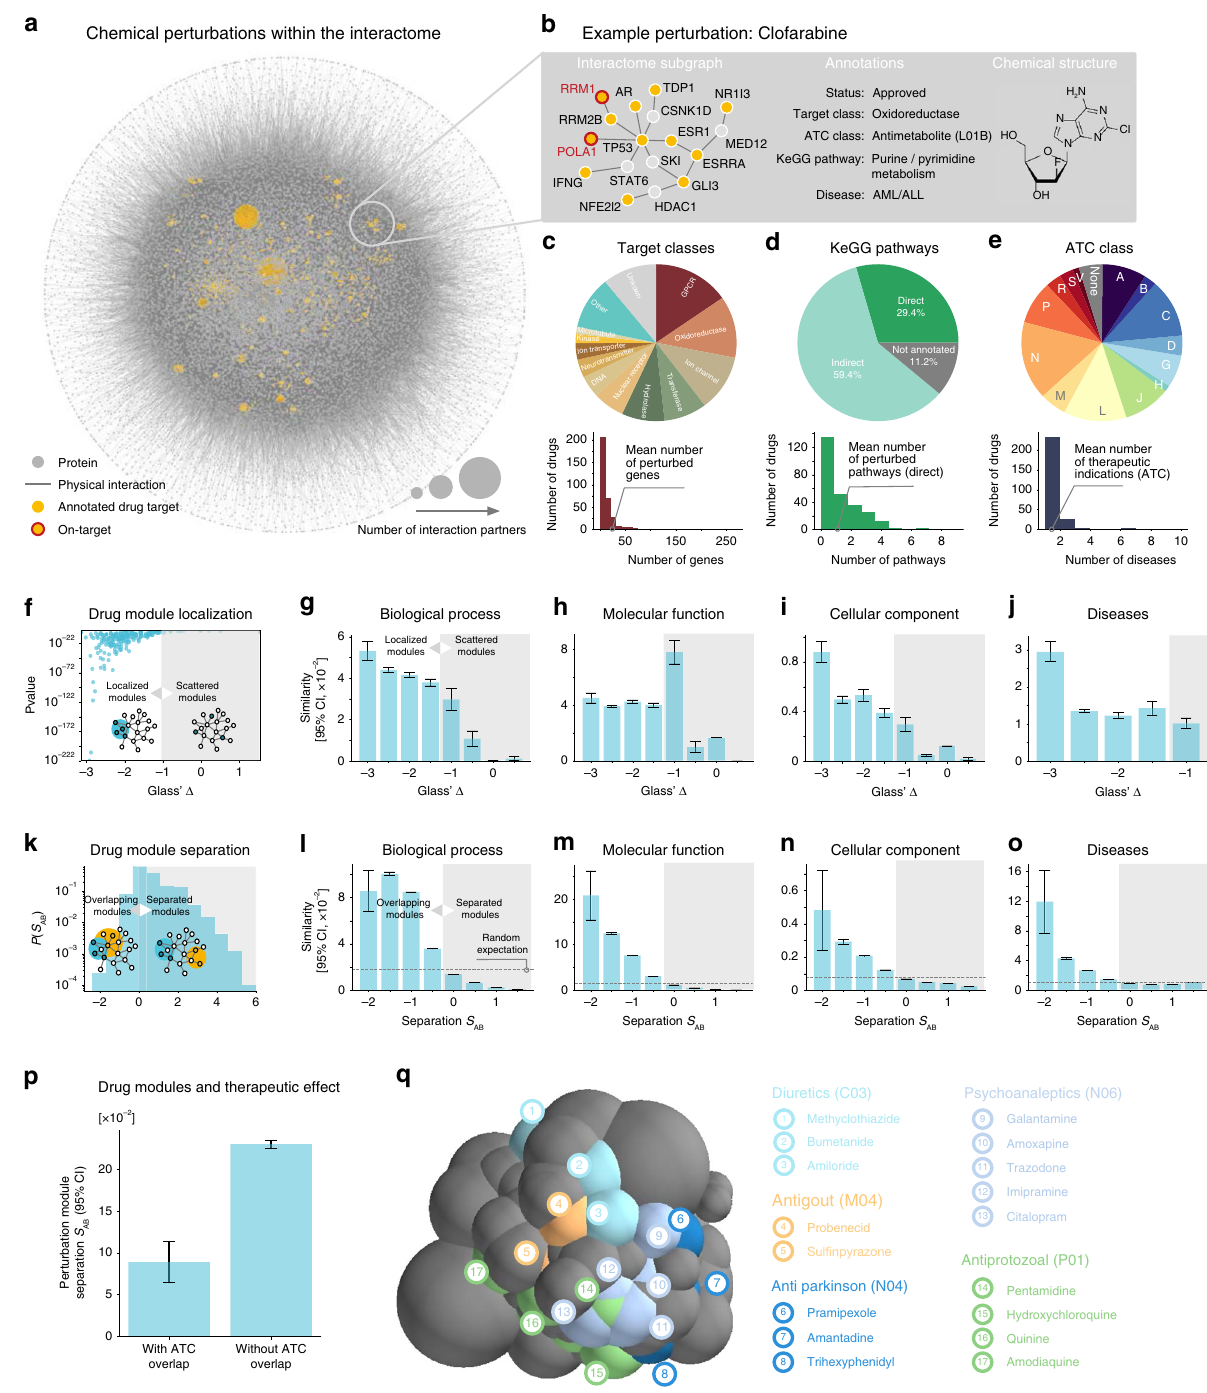
Fig. 1 The perturbation landscape of chemical compounds in the human interactome. a Interactome consisting of 16,376 proteins and 309,355 physical interactions, with 1096 unique targets of the 267 drugs used in this study highlighted in yellow. b Exemplary subgraph for one drug and summary of collected annotations. c – e Drug library overview: covered classes of protein targets ( c ), affected pathways ( d ), and therapeutic classes ( e ). f Drug targets form localized modules in the interactome (Glass ′ Δ < − 1 indicates strong localization). g – j Degree of localization correlates with similarity of biological processes ( g ), molecular function ( h ), cellular component ( i ), and known disease associations ( j ) of target proteins. k Distribution of interactome overlaps across all drug pairs ( S AB <0 indicates overlapping modules, S AB <0 separate ones). l – o Interactome overlap is associated with drug similarity in terms of biological processes ( l ), molecular function ( m ), cellular component ( n ), and known disease associations ( o ). p Drugs belonging to the same therapeutic class are characterized by overlapping interactome modules. The bars in g – j , l – p indicate the mean over all measurements, error bars show the 95% con fi dence interval. q Representation of interactome-based drug relationships in a 3D perturbation space. Each sphere represents a compound, the diameter is proportional to its interactome localization, the overlap between two spheres is proportional to their module overlap S AB . Five broad therapeutic disease classes are indicated in color. Modules of drugs that are used to treat similar diseases are co-located. We also observe overlaps between modules of drugs that are used to treat a particular disease and modules of drugs in which the respective disease may occur as a side effect NATURE COMMUNICATIONS| (2019) 10:5140